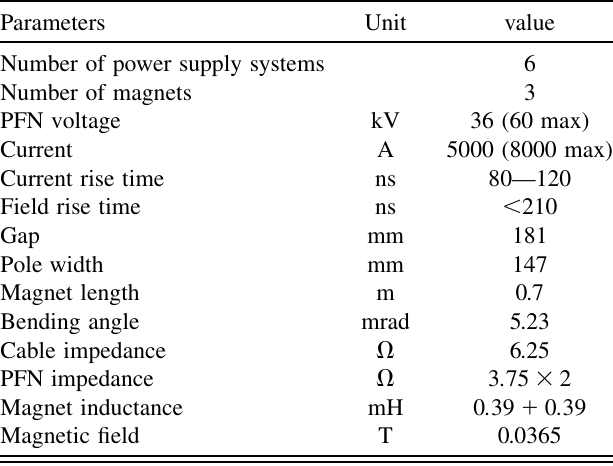
TABLE XXI. ISIS fast extraction kicker specifications.